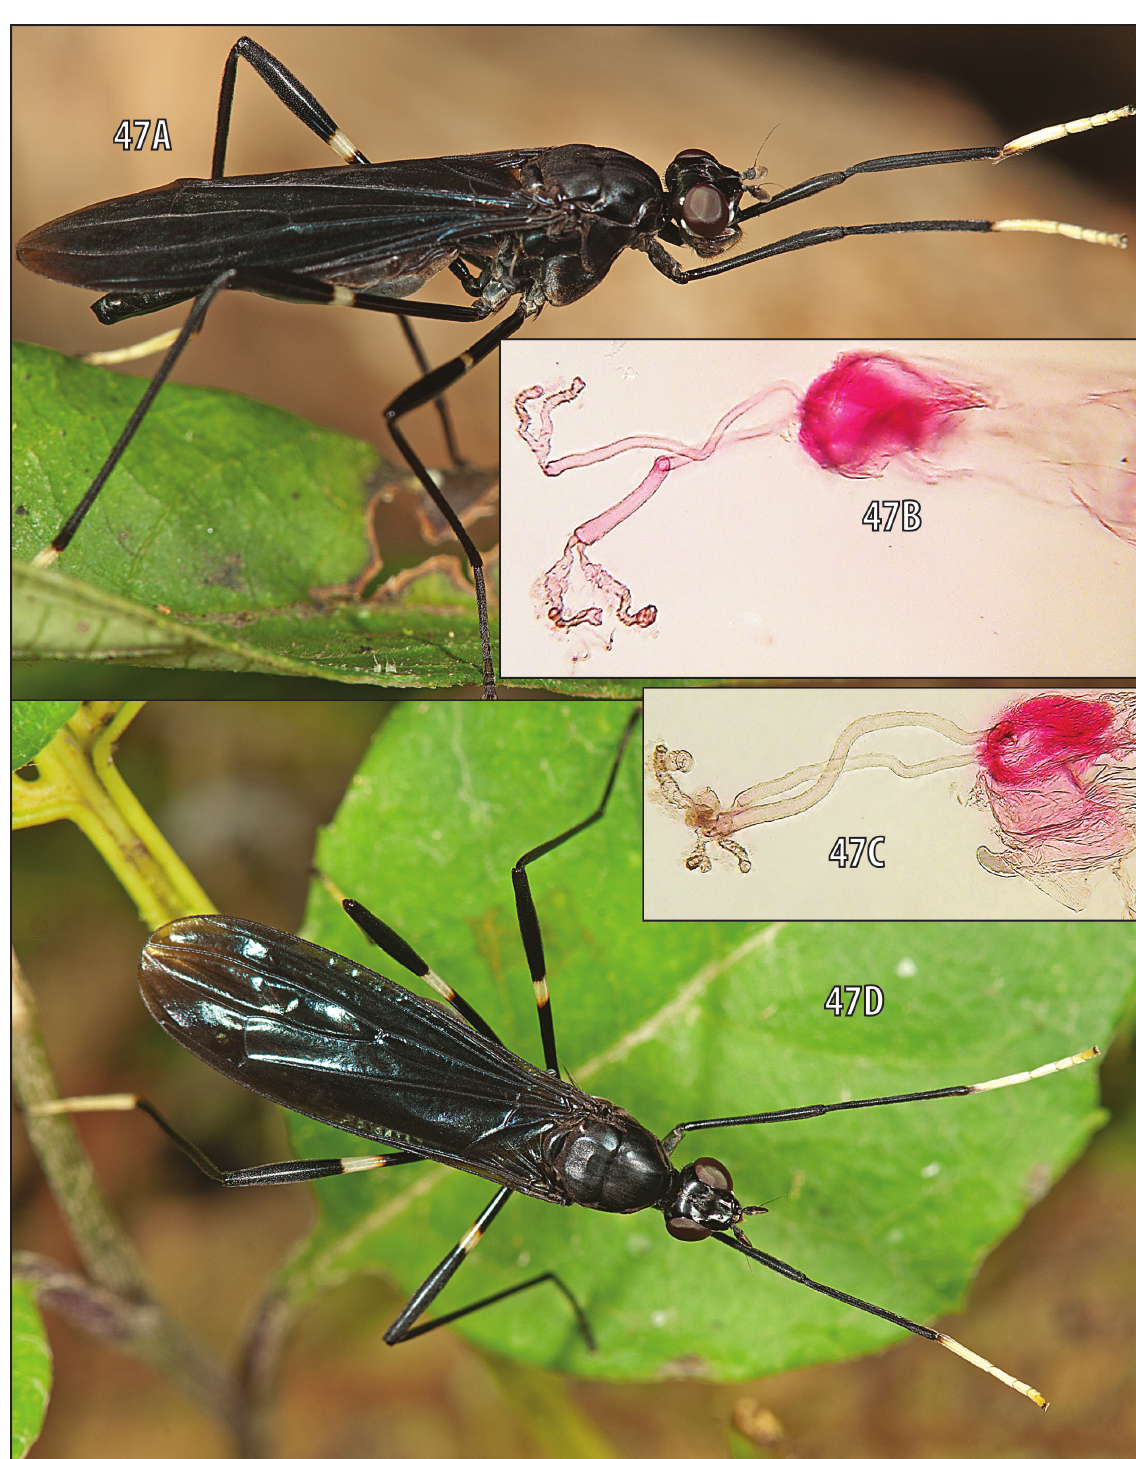
Fig. 47. Mesoconius quadritheca sp. nov . A , D . Living ♀♀. B–C . Spermatheca and associated structures, dorsal and lateral